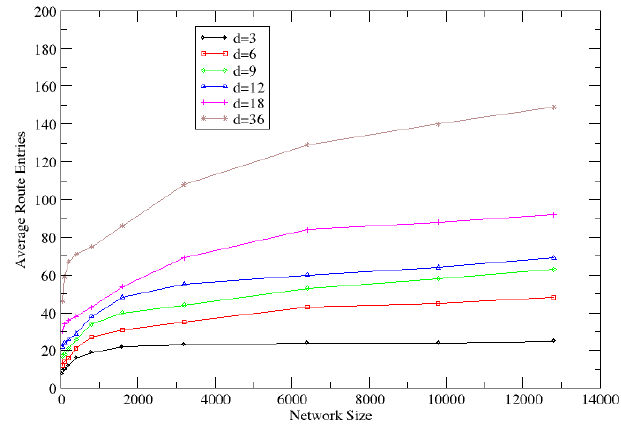
Figure 15. Average entries in each node‘s routing